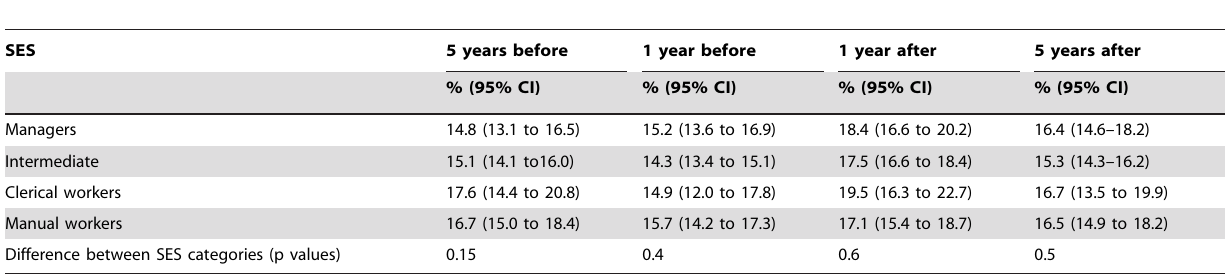
Table 2. Proportion (95% confidence intervals (95% CI)) of heavy drinkers in relation to retirement, by SES in men (from general estimation equation models).